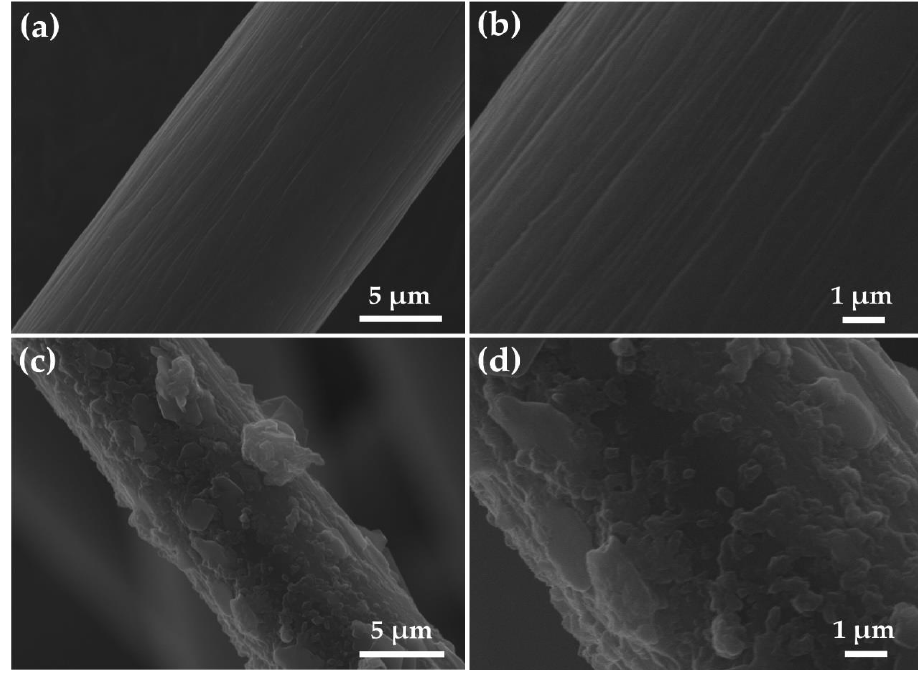
Figure 7. ( a , b ) SEM images of pristine graphite felt; ( c , d ) modified graphite felt with SnO 2 /rGO.